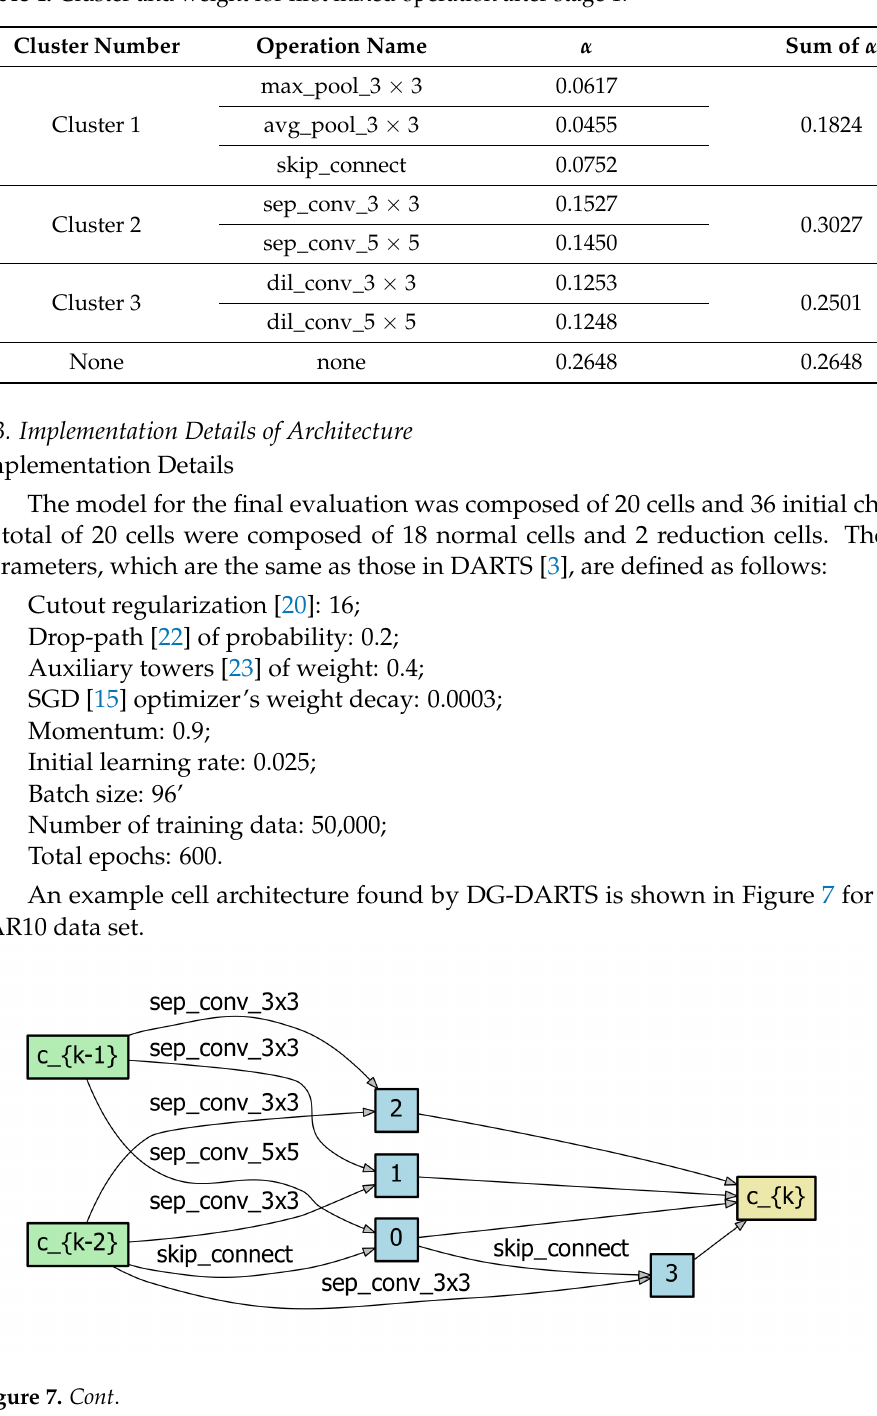
Table 4. Cluster and weight for first mixed operation after stage 1.